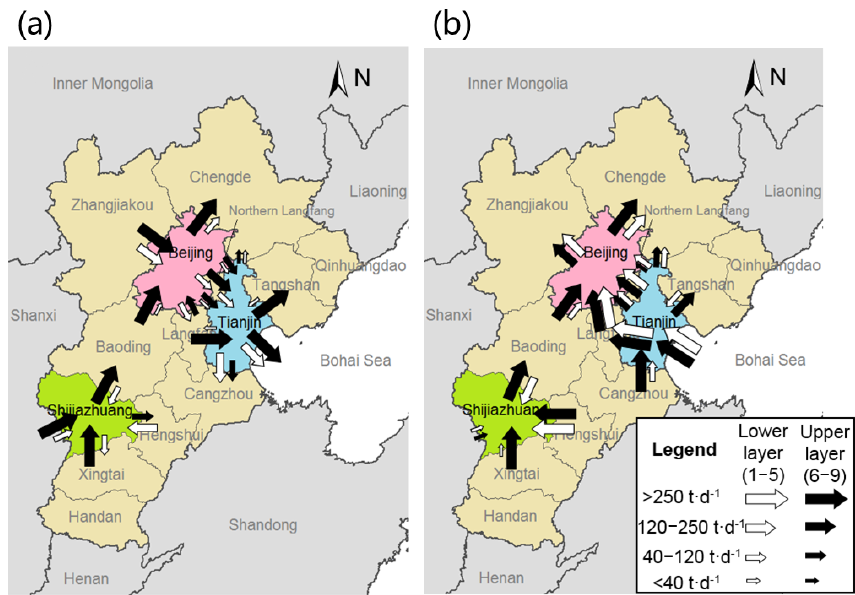
Figure 6. The transport fluxes through each boundary segment of the three target cities in January (a) and July (b) . The size of the arrows represents the amount of the fluxes, while white and black arrows denote fluxes at the lower (layer 1–5 in the model, from the ground to about 310m) and upper (layer 6–9 in the model, from about 310m to about 1000m) layers,